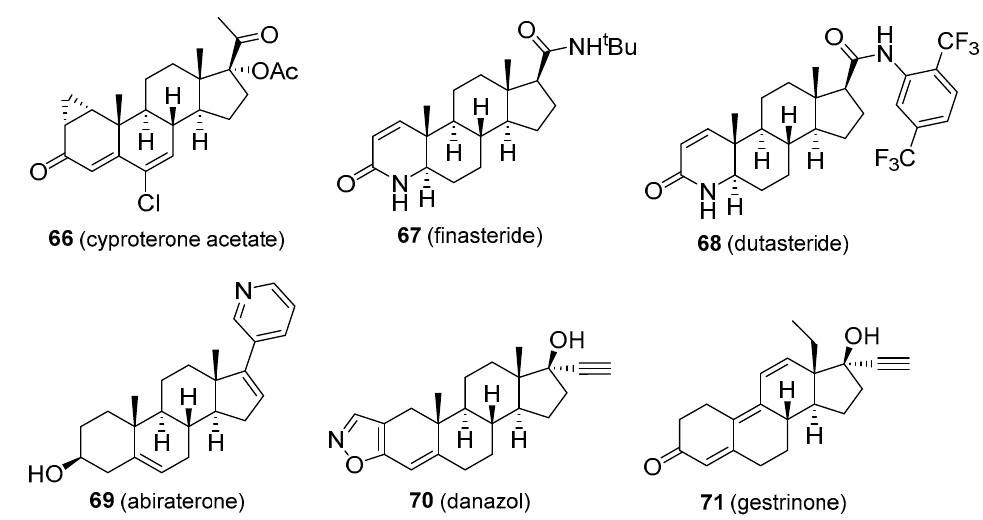
Figure 12. Molecular structures of anti-androgens.